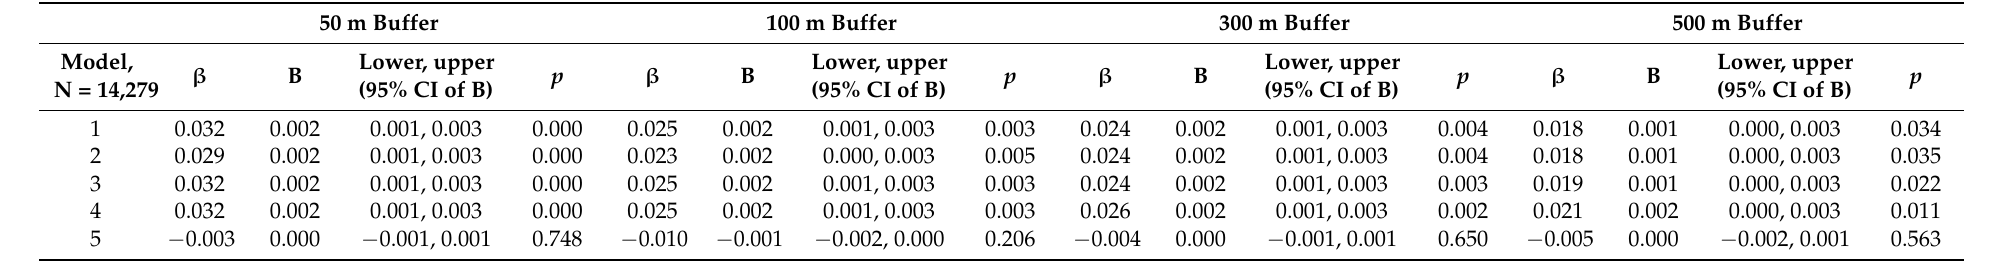
Table 6. Associations between residential greenspace at 50 m, 100 m, 300 m, and 500 m buffers, and life satisfaction (whole sample/population).